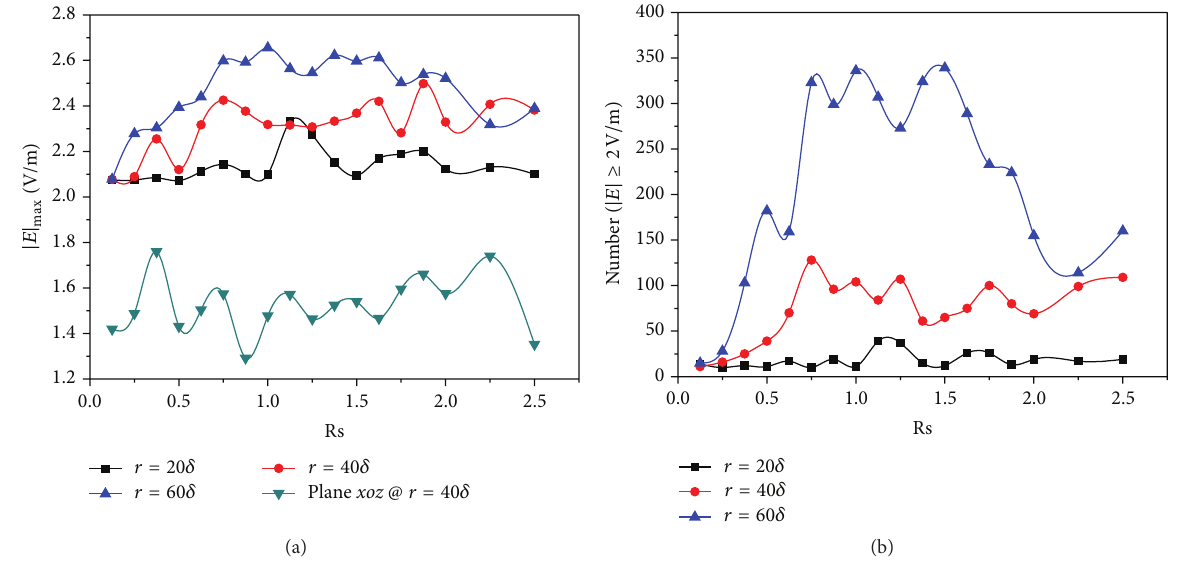
Figure 4: (a) |𝐸| max and (b) the number of high-intensity spots at various